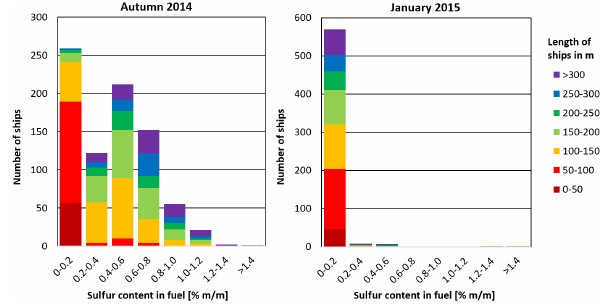
Figure 3. Sulfur fuel content in autumn 2014, and in January 2015, after the change of fuel regulations. The lengths of the ships that have been analysed are colour-coded. While in 2014 only small ships had fuel sulfur contents below 0.2%, nearly all ships fell into this category in January 2015.